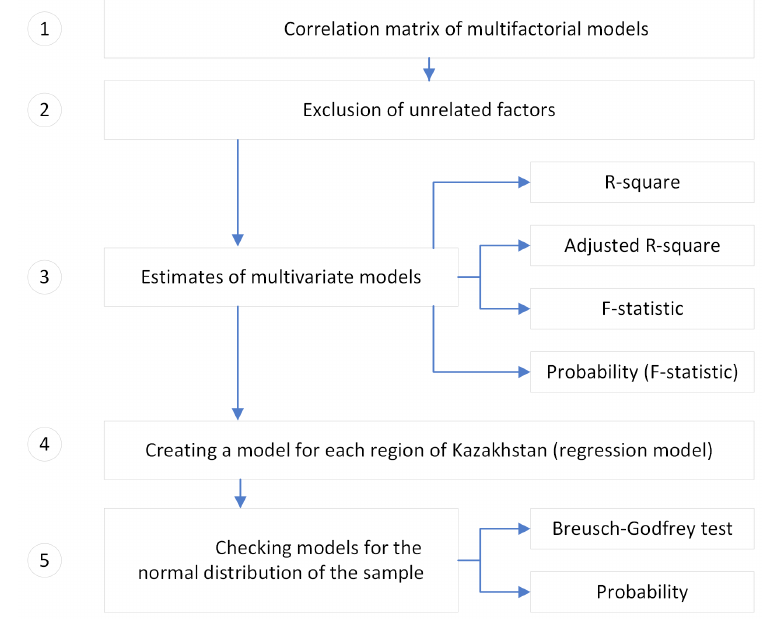
Figure 1. Stages of scientific